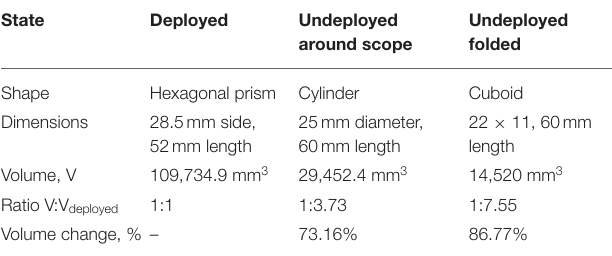
TABLE 2 | Summary of volume change of deployable robot in various states.